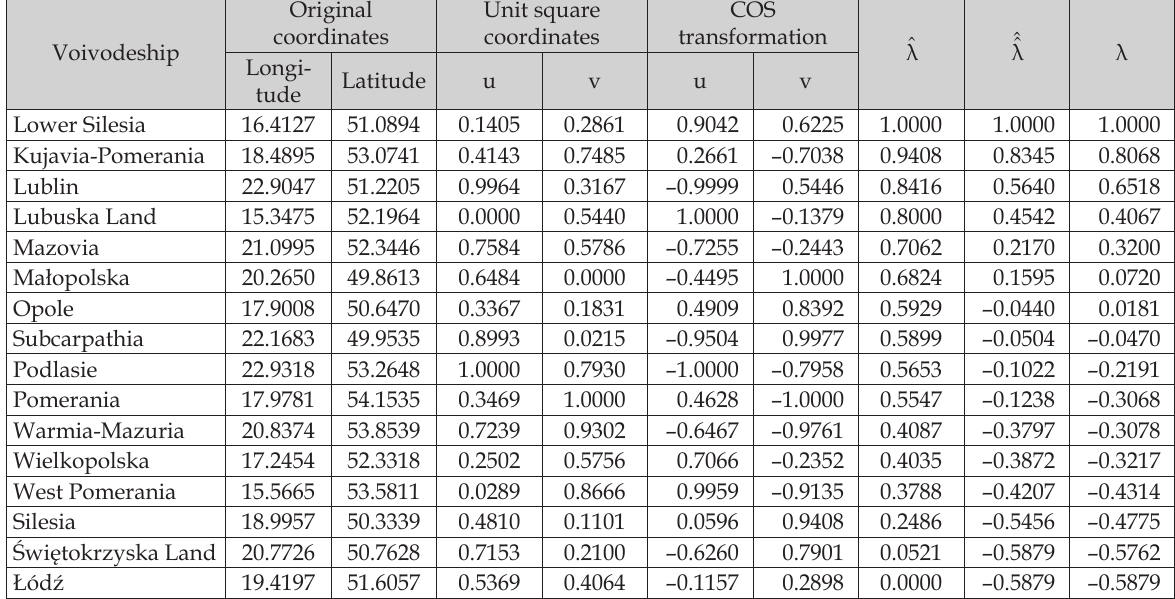
Table A1. Step-by-step details for geographic weights matrix